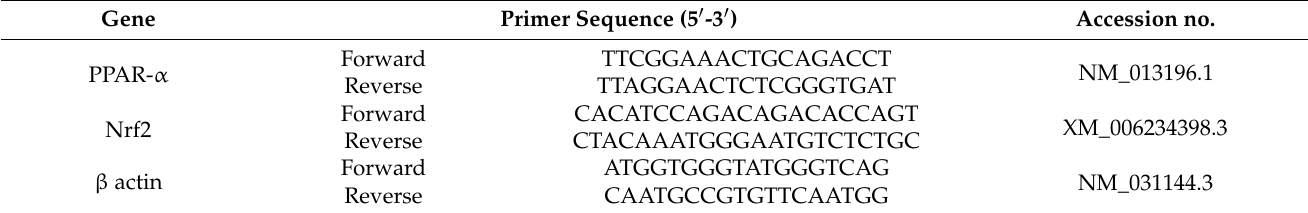
Table 1. Oligonucleotide primer